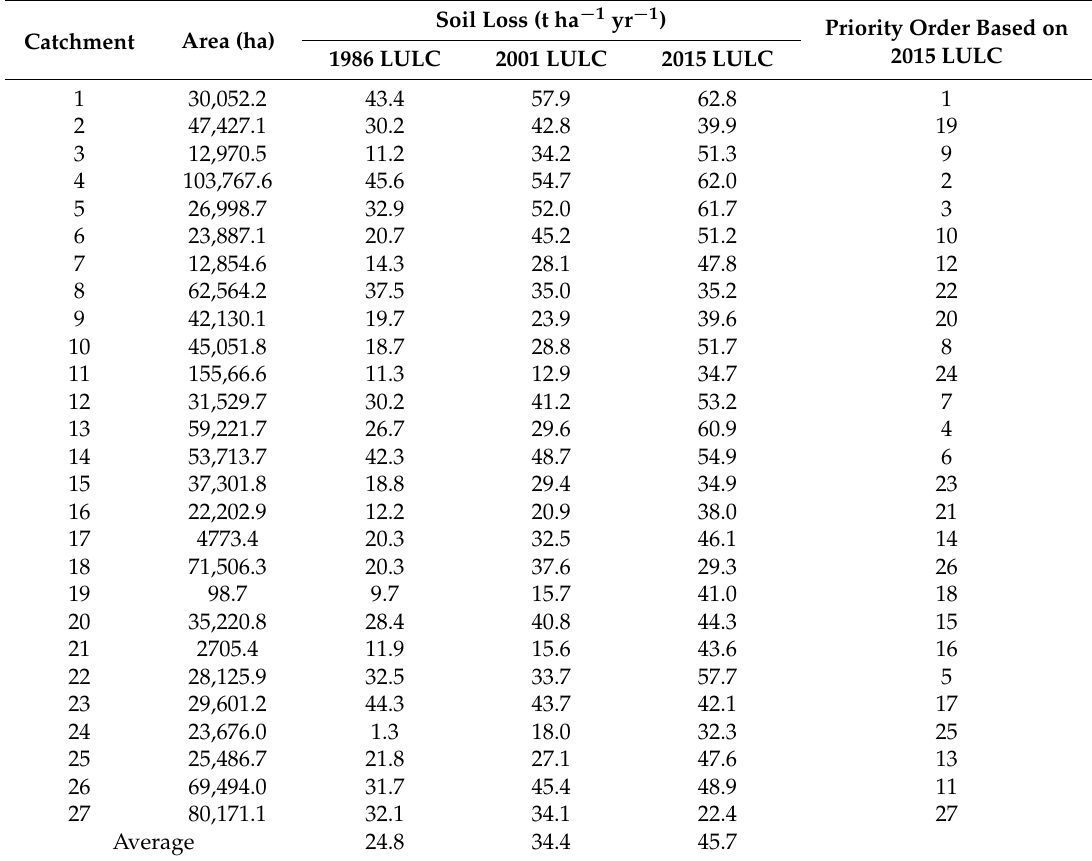
Table 9. Effect of LULCC on catchment soil loss and treatment priority order for the nearly current 2015